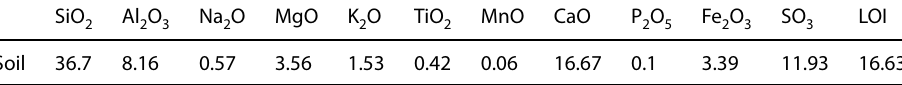
Fig. 4 XRD pattern graph of ML